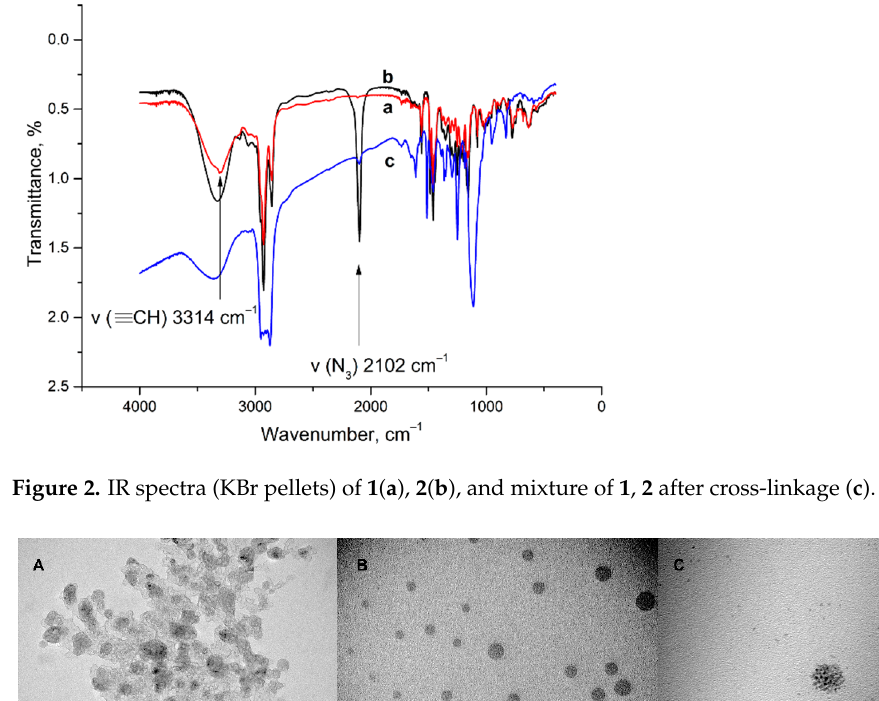
Figure 3. TEM images of empty polymeric particles ( 1 + 2 ) ( A ) and polymeric particles decorated with Pd ( B , C ).